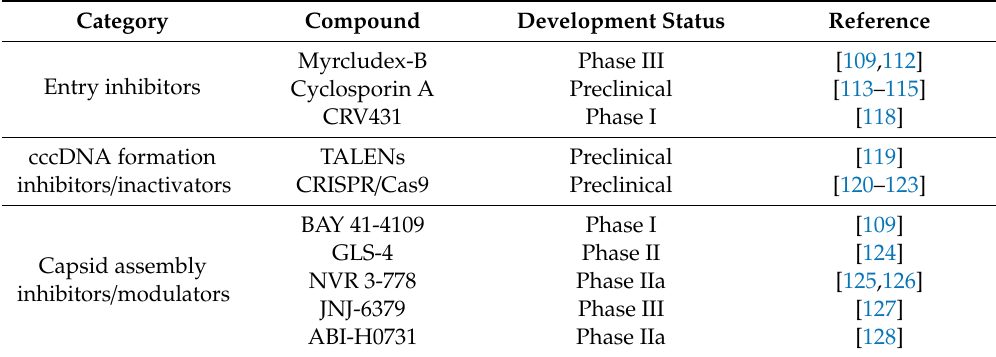
Table 2. The most important direct-acting antivirals for HBV under